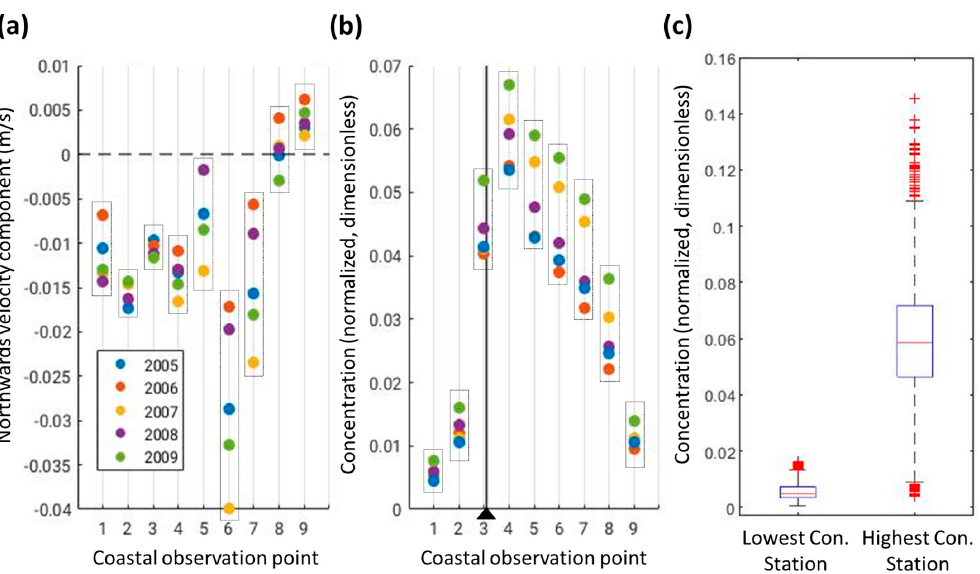
Figure 2. ( a ) Temporal average northwards velocity component (m/s). ( b ) Temporal average solute concentration (normalized, dimensionless). ( c ) Box-and-whisker plots of the statistics of concentration values (median, lower and upper quartiles, whiskers of 1.5 times the interquartile range, and individual outlier data outside of the whisker range) at the observation points with the lowest and the highest concentration. Results are for the Kalmar County coast and the symbol ▲ in panel ( b ) indicating the solute source location along this coastline.